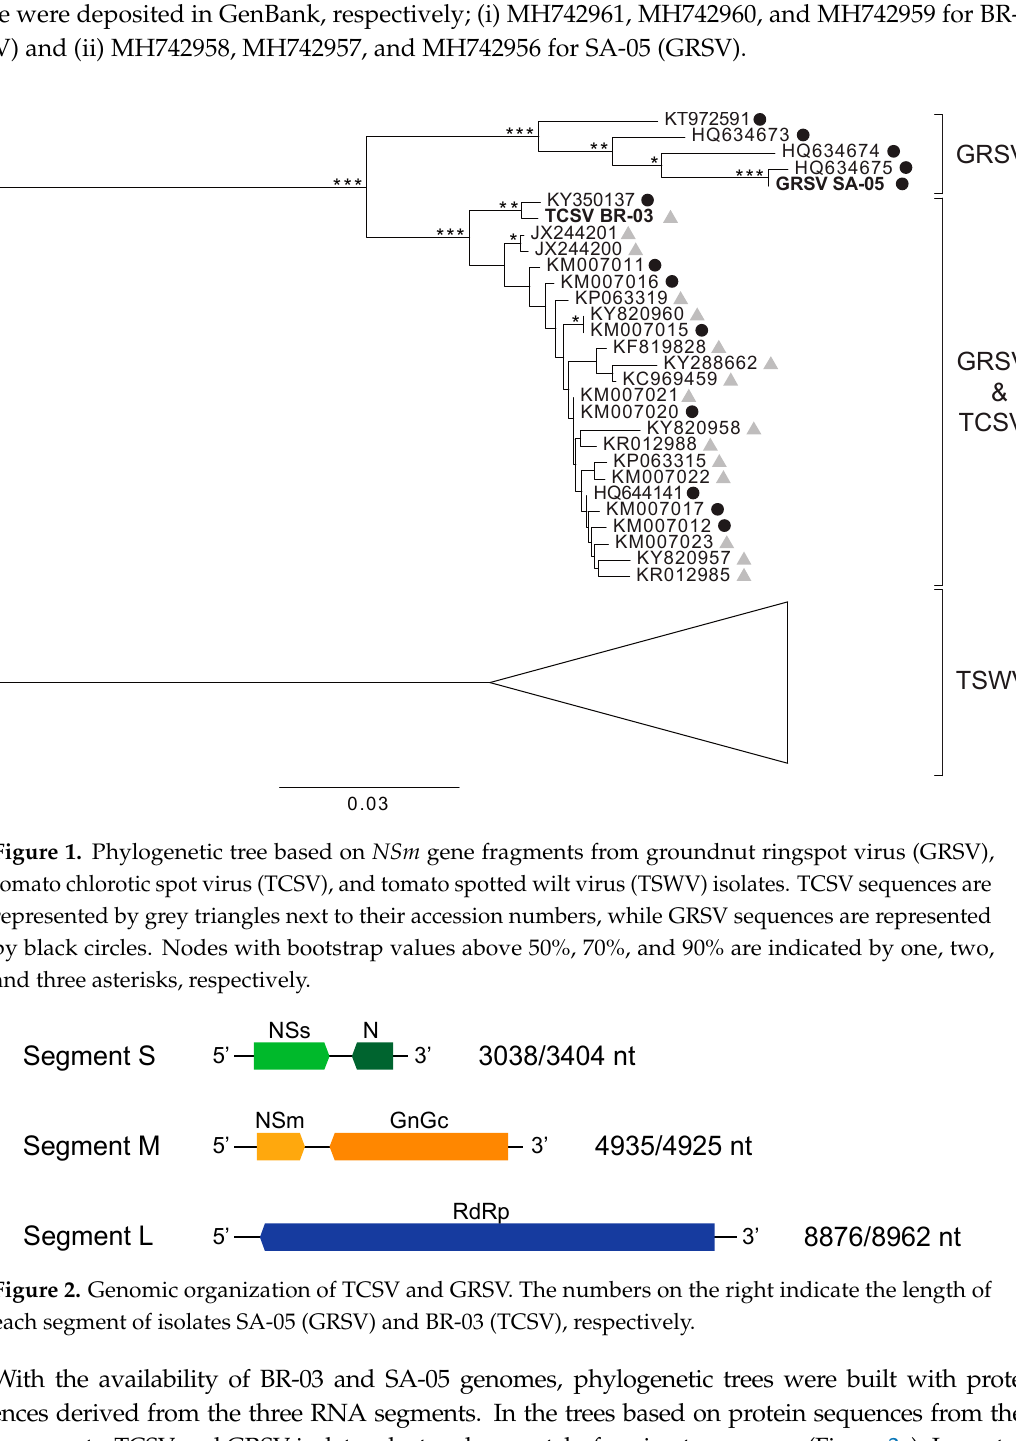
Figure 2. Genomic organization of TCSV and GRSV. The numbers on the right indicate the length of each segment of isolates SA-05 (GRSV) and BR-03 (TCSV), respectively.